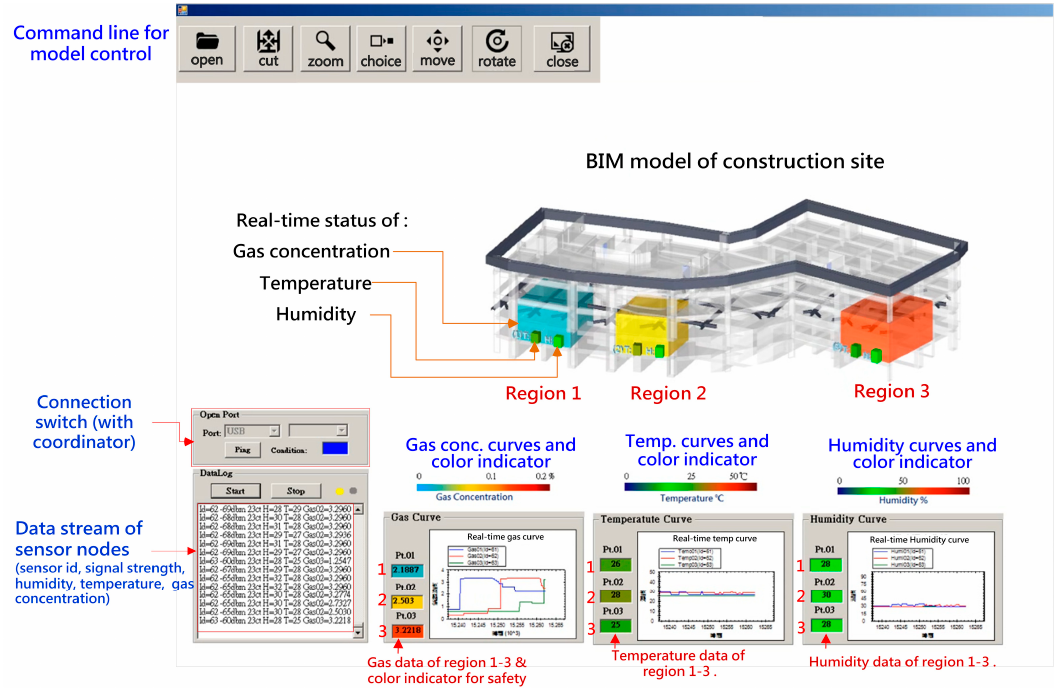
Figure 12. Screenshot of the integrated system.